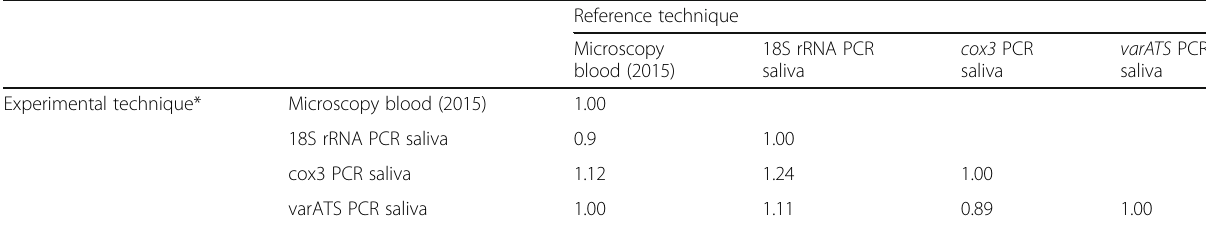
Table 2 Comparison of the efficiency of thick-film microscopy and PCR